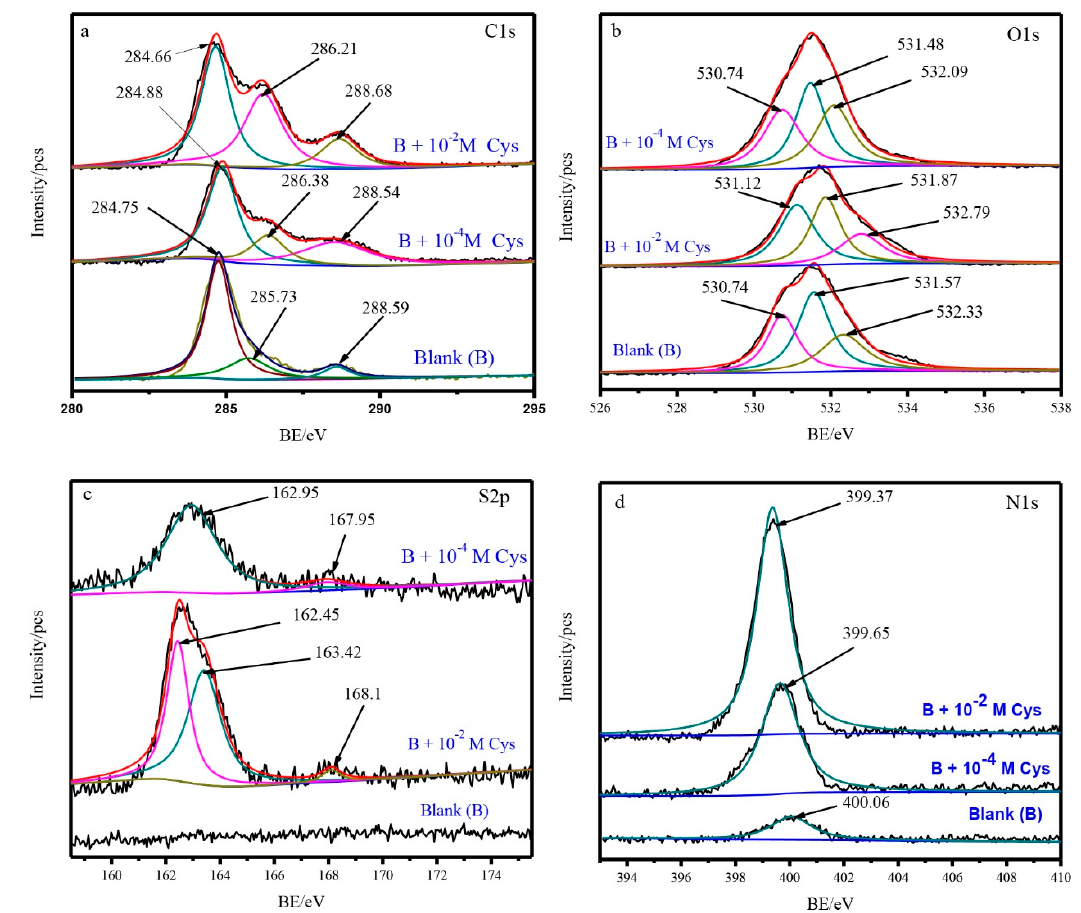
Figure 8. High-resolution XPS C1s ( a ), O1s ( b ), S2p, and N1s spectra of the Cu5Zn5Al1Sn alloy surface before and after addition of inhibitors in 3.5 wt.% NaCl solution ( c , d.